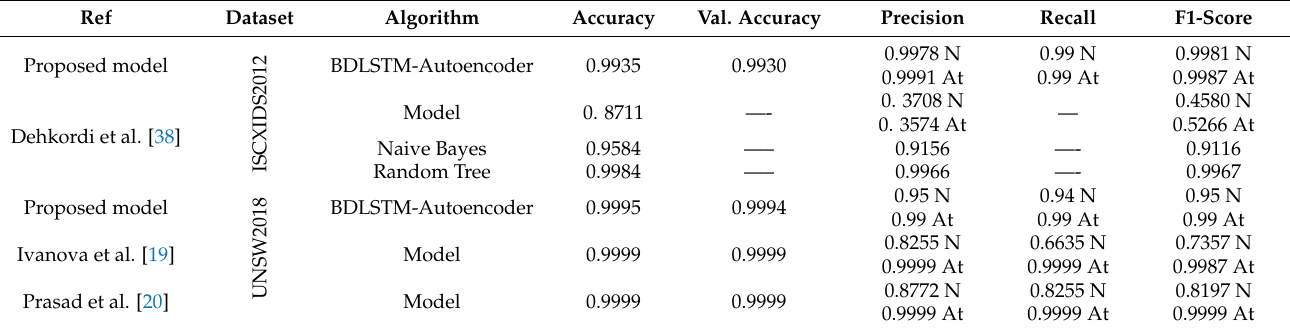
Table 7. Comparison results between BDLSTM-autoencoder model and some recent works.